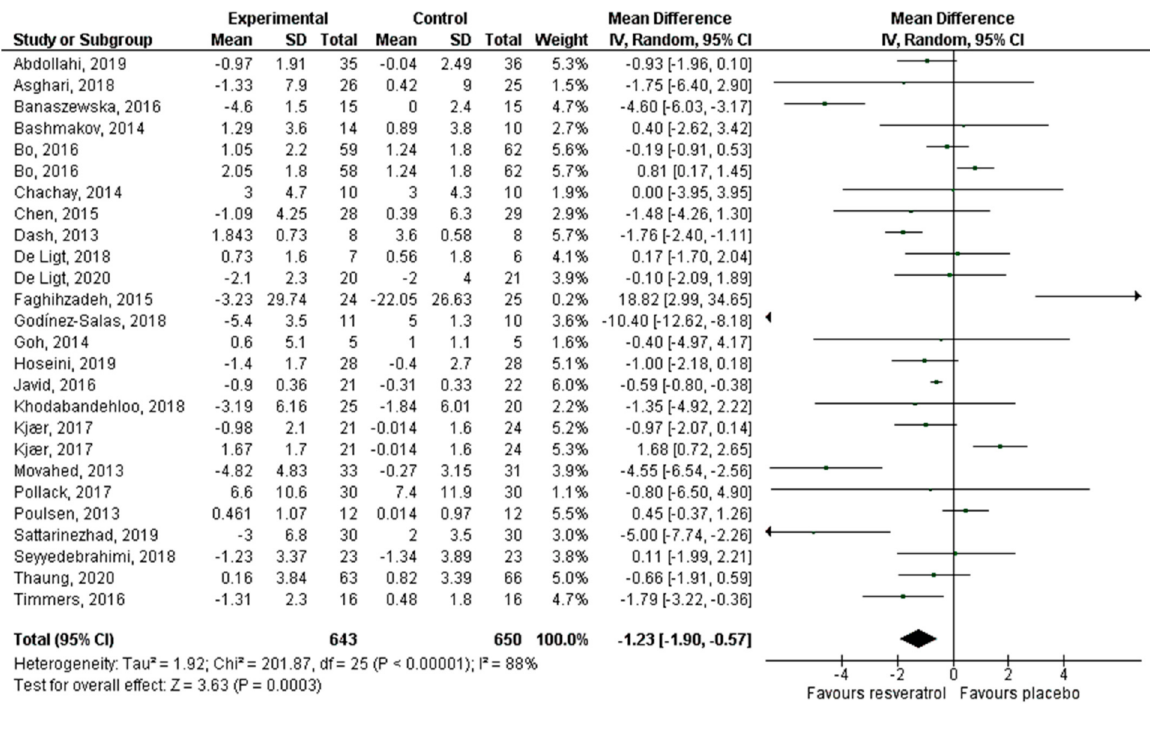
Figure 4. Effect of resveratrol on insulin